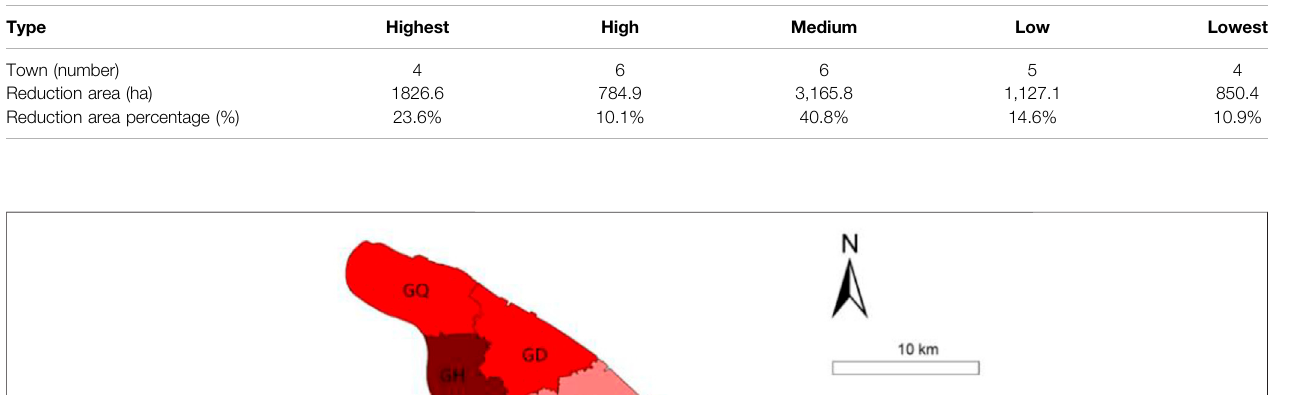
Frontiers in Environmental Science |